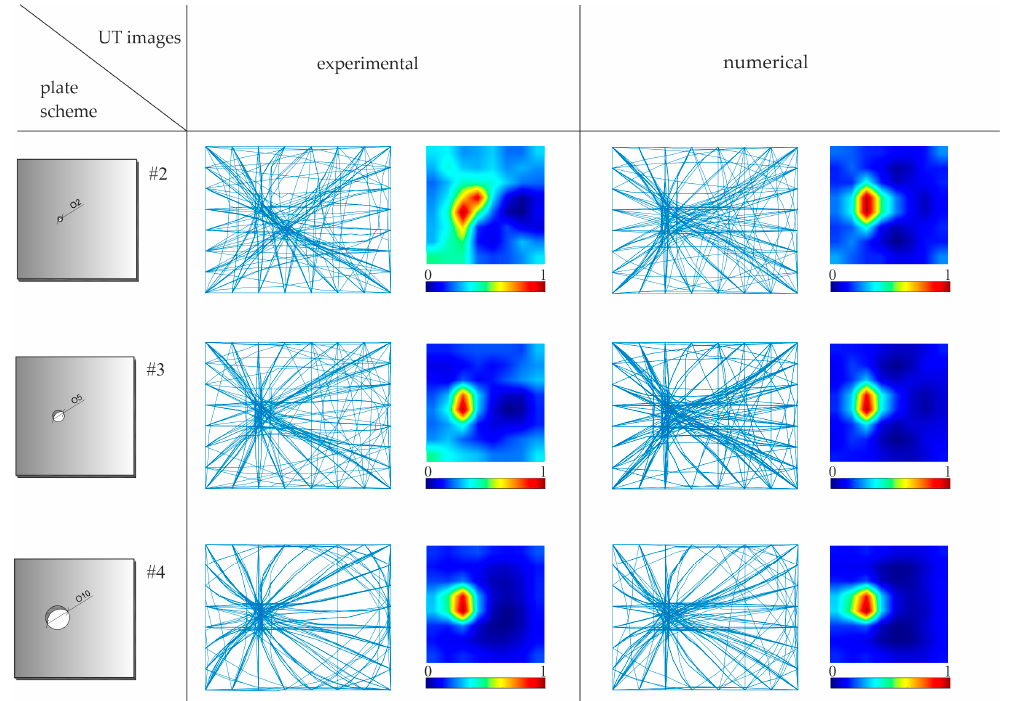
Figure 14. Ultrasonic tomography (UT) maps using the method of signal differences with curved paths.